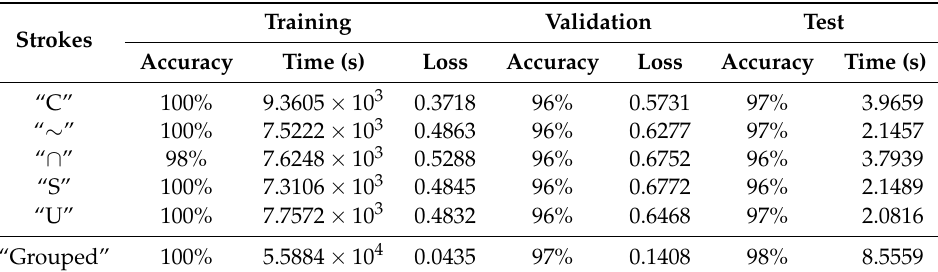
Table 11. Original Simple Grapheme - ResNet-18 (epoch = 80).